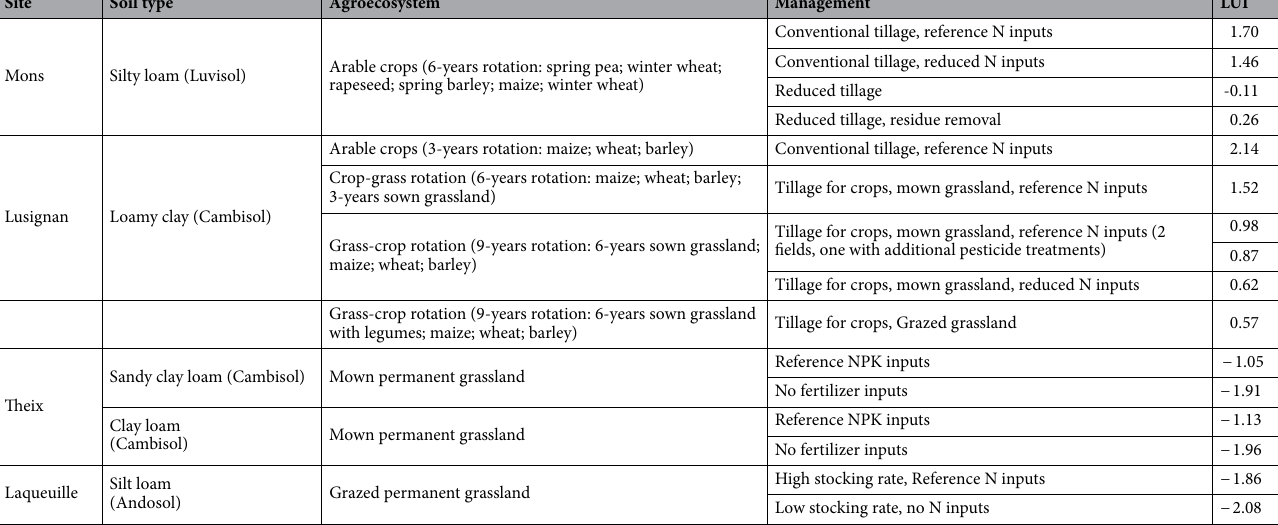
Table 1. Soil type, management and land-use intensity (LUI) ranking for the sixteen experimental fields in France. Values for LUI are based on a multicriteria evaluation (Supplementary Fig. S2); more positive values indicate more intensive management practices. Mean annual temperature and rainfall of sites as follows: Mons: 11.7 °C, 614 mm; Lusignan: 11.7 °C, 800 mm; Theix: 8.7 °C, 780 mm; Laqueuille: 8 °C, 1000